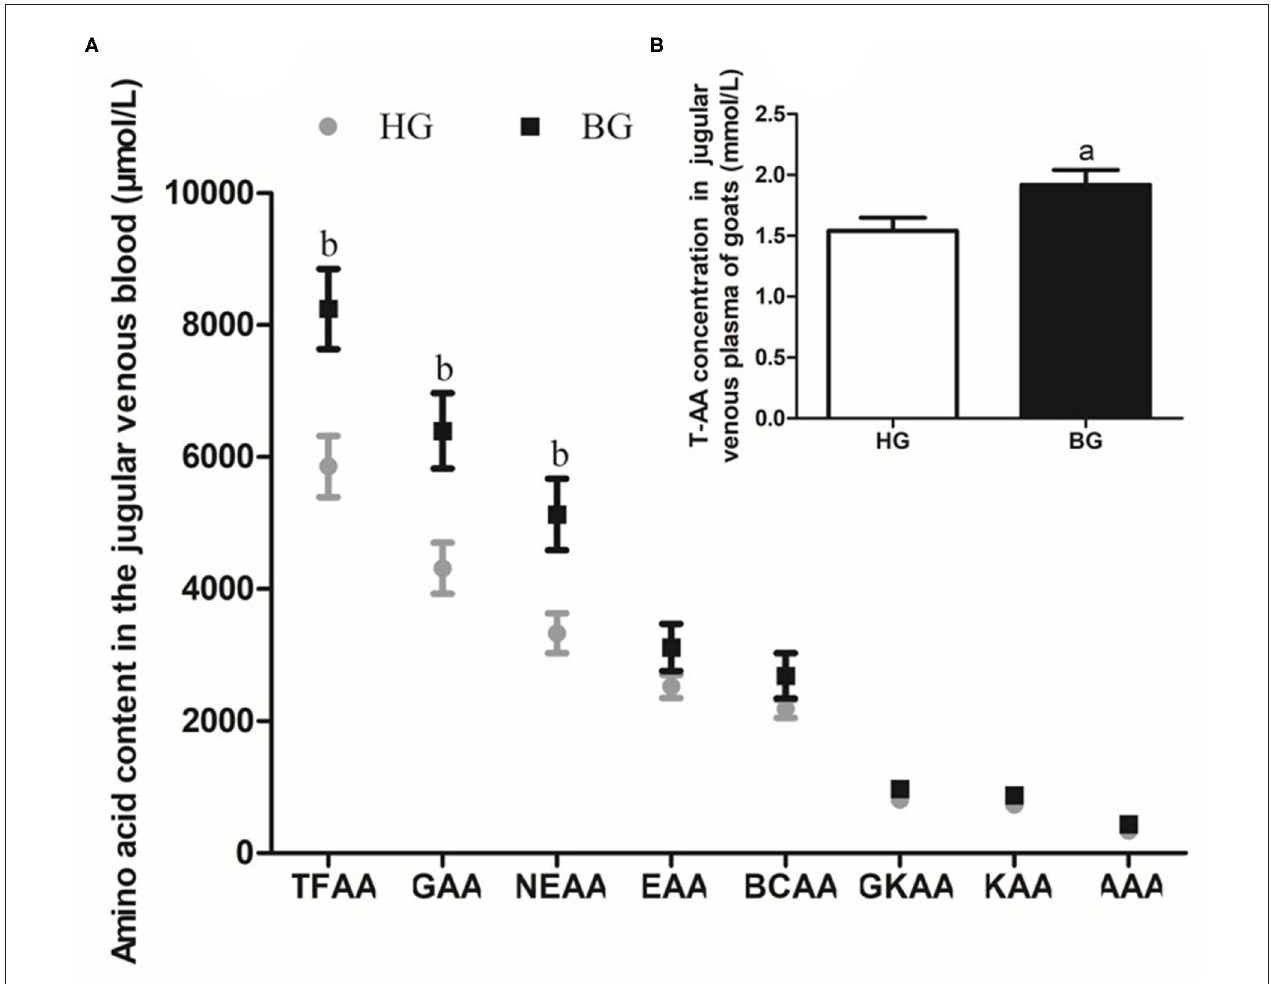
FIGURE 3 | Different types of amino acids content in plasma of lactating goats. (A) Impact of high-grain diet with buffering agent on different types of amino acids content in plasma of lactating goats by HPLC. (B) Impact of high-grain diet with buffering agent on total amino acids content in plasma of lactating goats by Total Amino Acid assay kit. Values are mean ± SEM, n = 6/group. b p < 0.05 and a p < 0.01, compared with high grain group. TFAA, total free amino acid; GAA, glycogenic amino acid; NEAA, non-essential amino acid; EAA, essential amino acid; BCAA, branched-chain amino acid; GKAA, glucogenic and ketogenic amino acid; KAA, ketogenic amino acid; AAA, aromatic amino